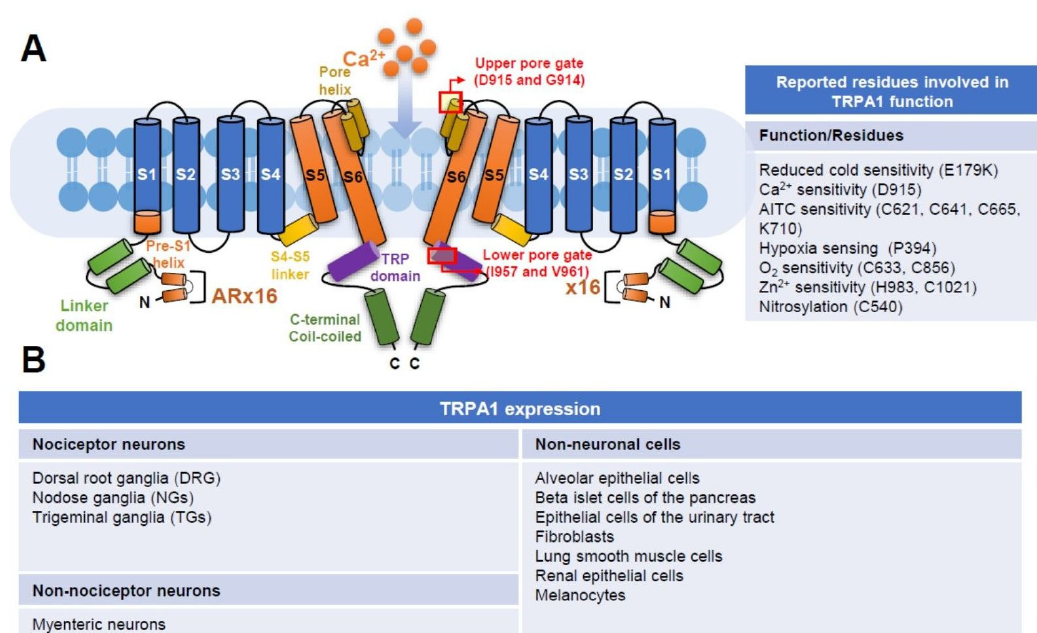
Figure 1. Structure and expression of TRPA1. ( A ) Key features of the ion channel TRPA1 mediating the cellular influx of calcium ions (Ca 2+ ) are illustrated. Similar to other TRP channels, TRPA1 possesses a tetrameric structure, and a single pore is present along the central axis. Two subunits are shown here. Each subunit consists of six transmembrane alpha helices (S1–S6 domains), followed by two pore helixes, a TRP-like domain and an intracellular C-terminal domain. In the intracellular N-terminal, 16 ankyrin repeats (AR) are unique and speculated to contain the cysteine residues targeted by electrophilic TRPA1 activators. The molecular interactions of ligands with ARs may lead to conformational changes through the S4–S5 linker structure and subsequently open the channel. The location of reported upper and lower gates formed by residues D915/G914 and I957/V961, respectively, is shown. Protein residues reportedly involved in TRPA1 function or ion sensing are listed. ( B ) Expression of TRPA1 in selected neurons and non-neuronal